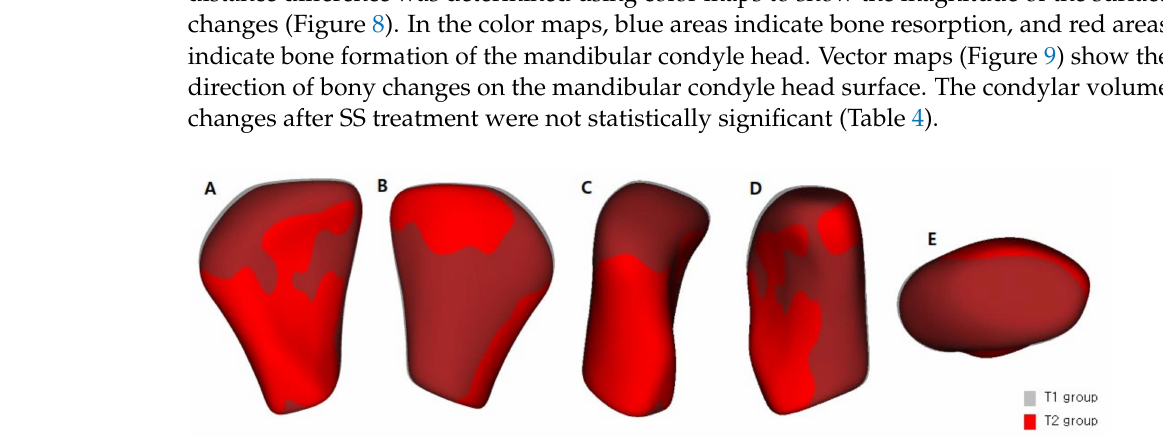
Figure 7. Group comparison using shape analysis—semi-transparent overlays pre-treatment (T1) and post-treatment (T2); ( A ), anterior view; ( B ), posterior view; ( C ), lateral view; ( D ), medial view; ( E ), superior view.